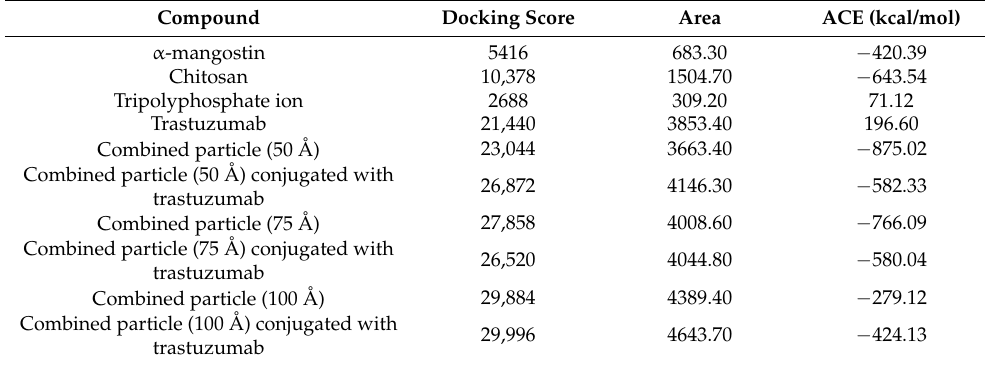
Table 5. Molecular docking simulation results of the preparation and its standards against HER2.